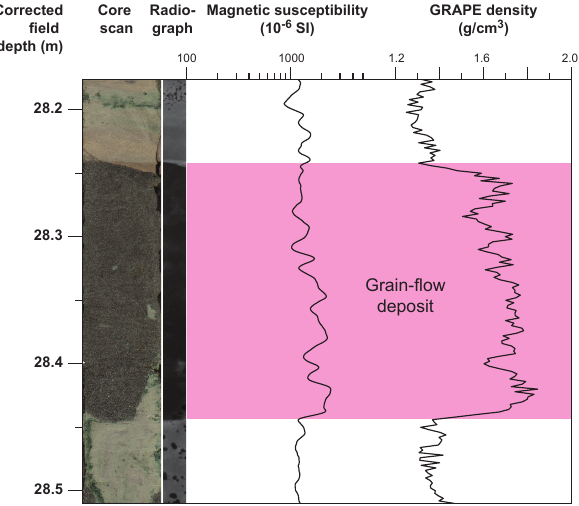
Fig. 3. Turbidite T42 (age 482ka) in a core scan from 5011-1A- 6H-1 resembles a “Bouma sequence” (Bouma, 1962). The differ- ent subunits of the turbidite are readily identifiable from the red- dish pelagic sediment based on color. The upper boundary of T42 is obscured by a greenish redox layer, but compositional grading is revealed by radiograph, magnetic susceptibility and density. Both magnetic susceptibility and density are high at the base of the tur- bidite and decrease towards the clayey top. Intra-bed boundaries (dashed line) between subunits are marked by “steps” in magnetic susceptibility and density values.